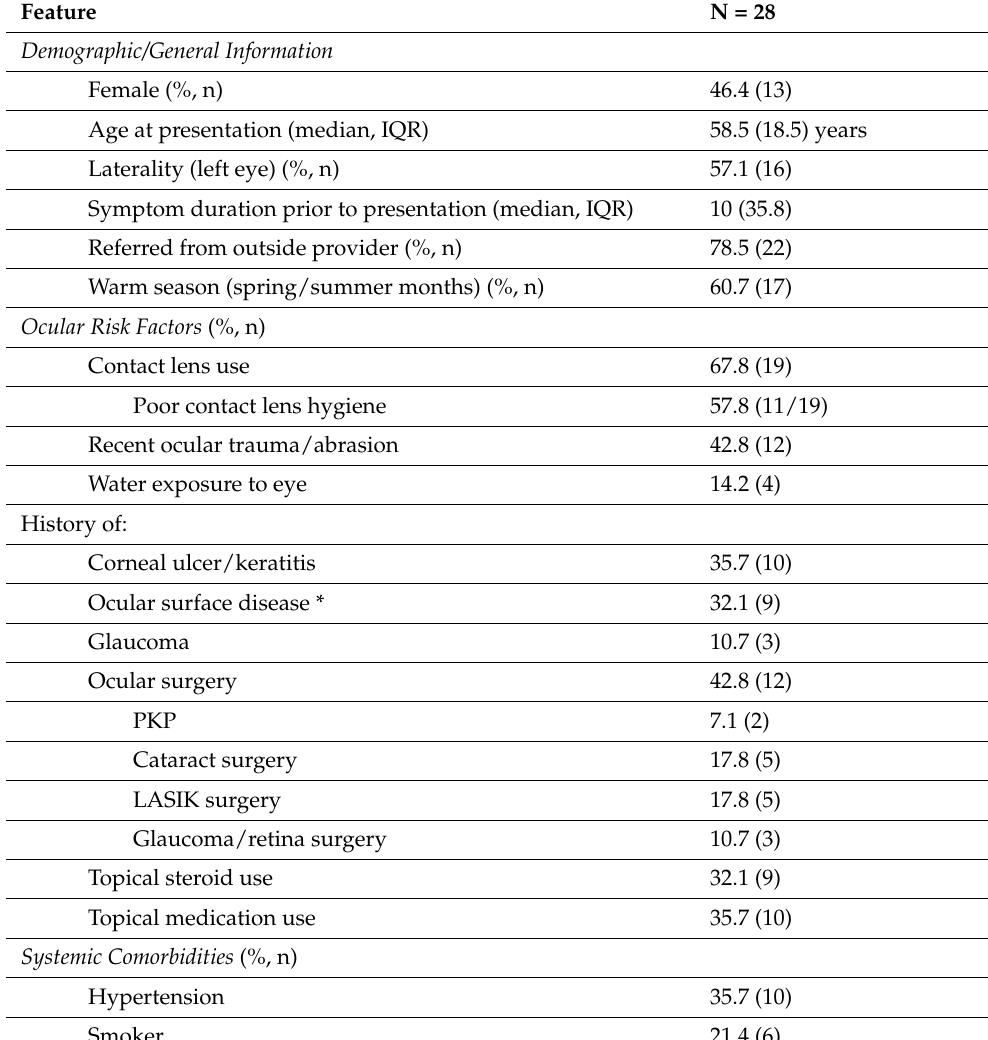
Table 1. Clinical profile of patients with fungal keratitis at